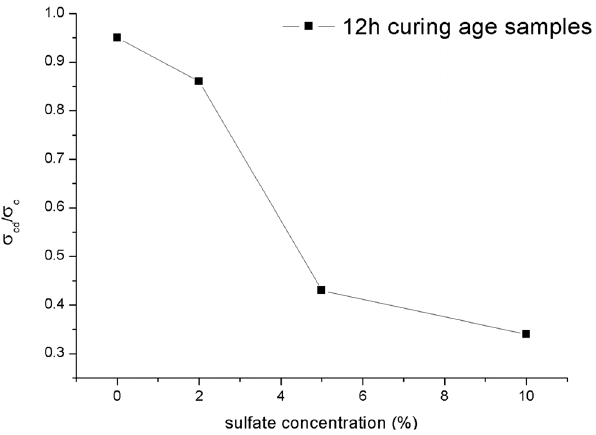
Figure 17. Ratio σ (cid:2913)(cid:2914) /σ (cid:2913) for samples under different concentrations of sulfate attack. 410 Figure 17. Ratio σ cd / σ c for samples under different concentrations of sulfate